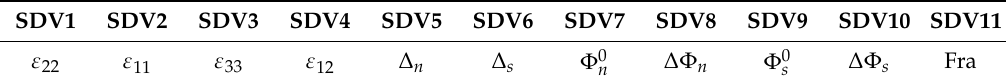
Table 6. State variable